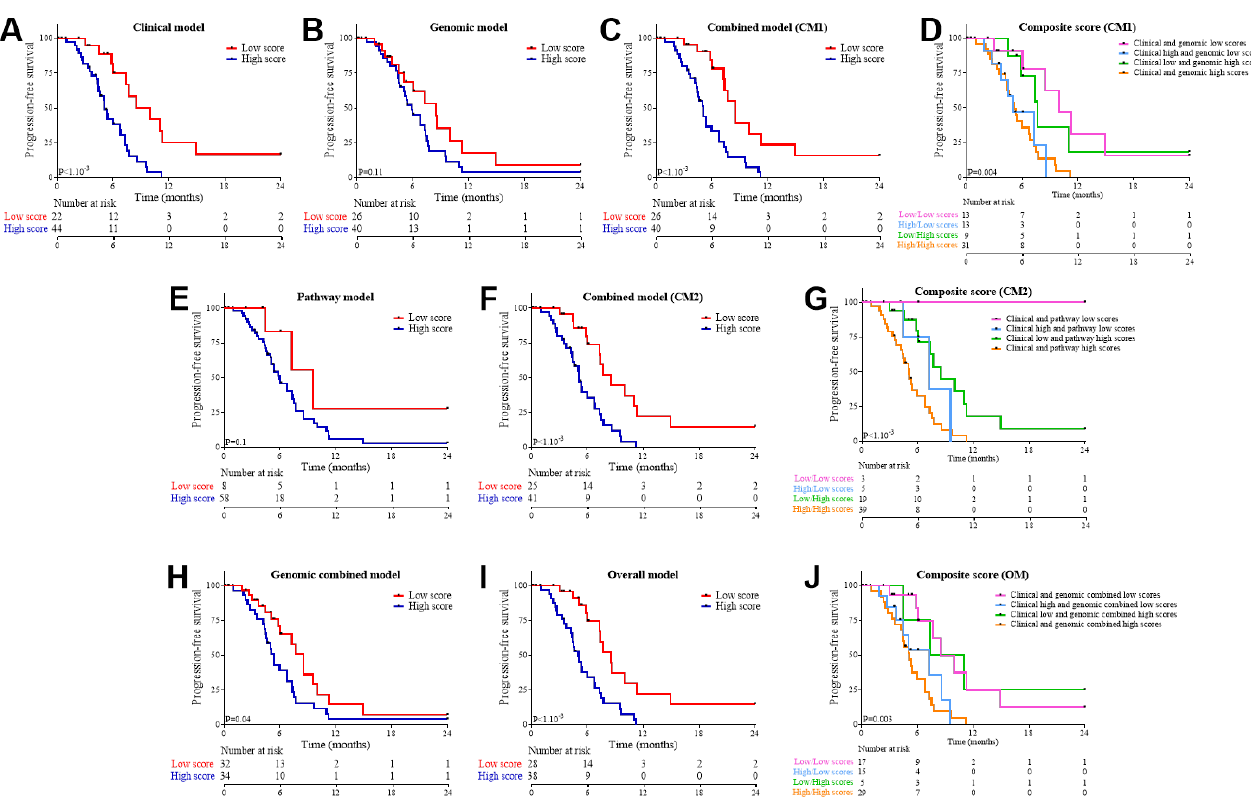
Figure 3. Validation of the overall survival models on progression-free survival in the FOLFIRINOX group. Kaplan–Meier curves for progression-free survival with patients stratified according to scores estimated through overall survival models: the clinical score ( A ), the genomic score ( B ), the CM1 score ( C ), the low vs. high score (a composite score combining clinical and genomic scores) ( D ), the pathway score ( E ), the CM2 score ( F ), a composite score combining clinical and pathway scores ( G ), the genomic combined score (genomic variables and pathways) ( H ), the overall score ( I ), and a composite score combining clinical and genomic combined scores ( J ).